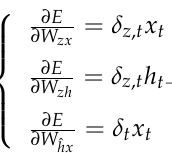
where E denotes the loss of the sample. The GRU network reaches the optimum after training each parameter. The structure of the GRU gated recurrent unit is shown in Figure 2.